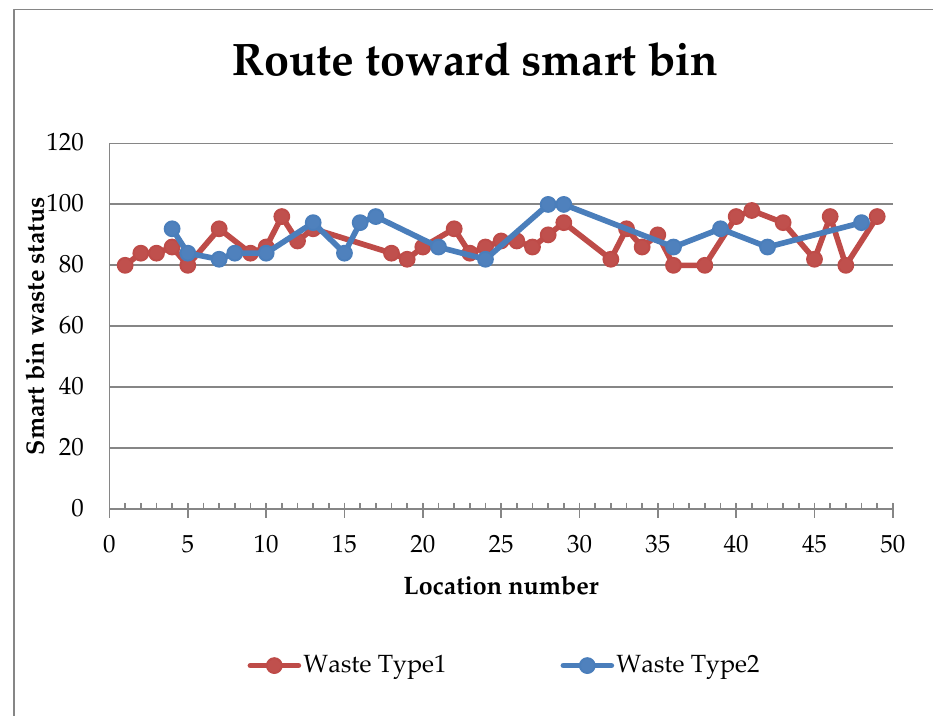
Figure 21. The route towards the smart bin.